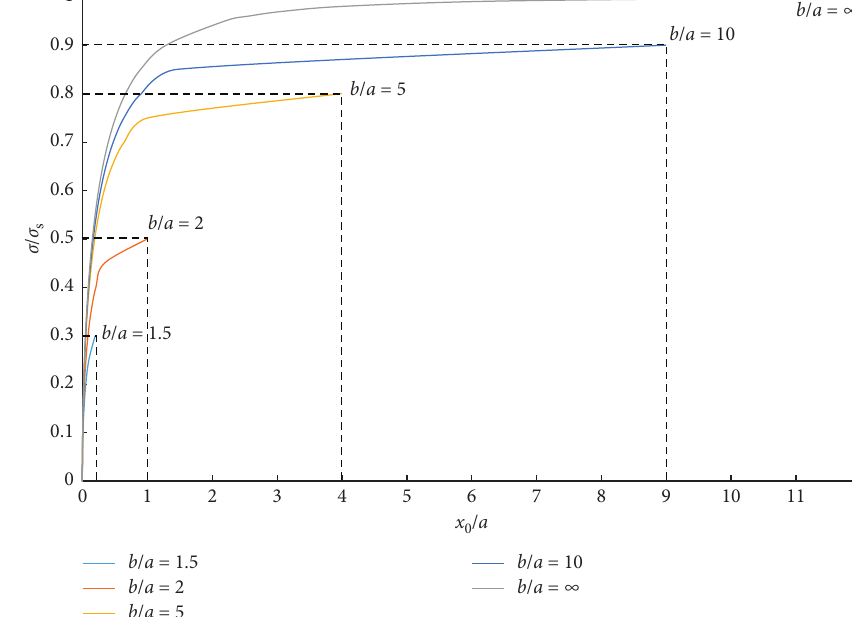
Figure 3: Comparison of variations of ( x